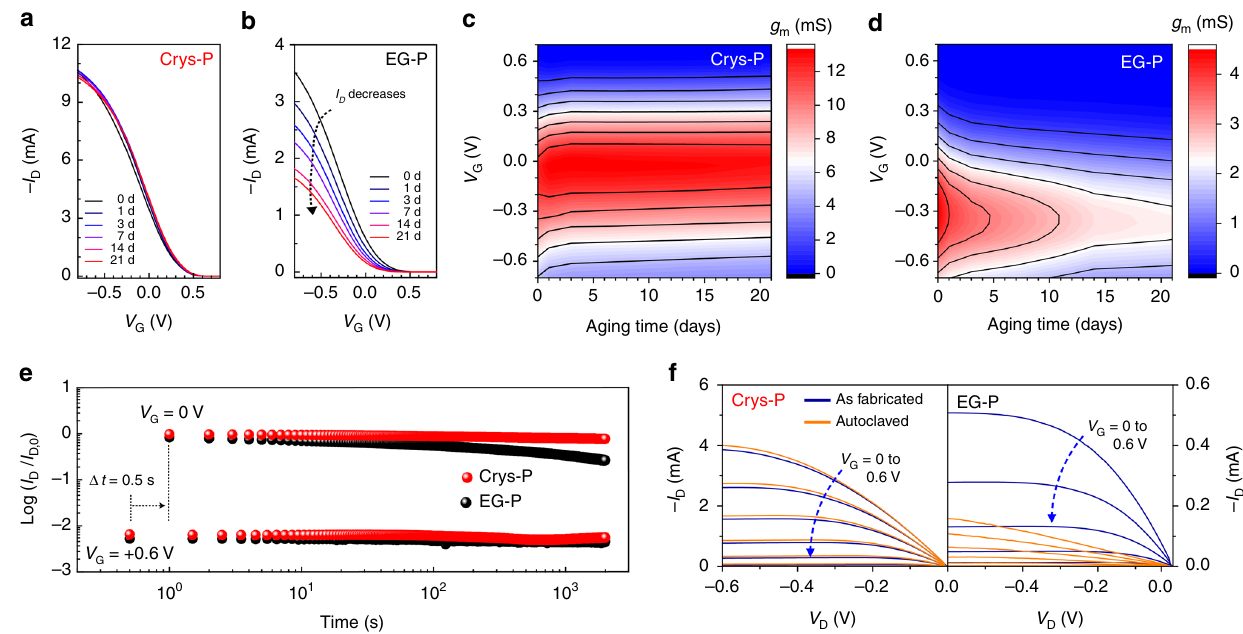
Fig. 5 Aqueous stability of Crys-P and EG-P OECTs. a The saturation-regime transfer curves of crystallized PEDOT:PSS (Crys-P) and b 5% ethylene glycol- treated PEDOT:PSS (EG-P) OECTs over aging time in an aqueous 0.1 M NaCl solution. c The color-coded contour plots of transconductance ( g m ) of Crys-P and d EG-P fi lms measured at the same condition as in ( a , b ). e Normalized current on/off ratio traced during the repeated V G switching up to 2000 cycles ( V G = 0.6 V [off] and 0 V [on], Δ t = 0.5 s). f Output characteristics of Crys-P (left panel) and EG-P (right panel) OECTs before (blue curves) and after (orange curves) autoclave sterilization while V G was swept from 0 to 0.6 V with the increment of 0.1